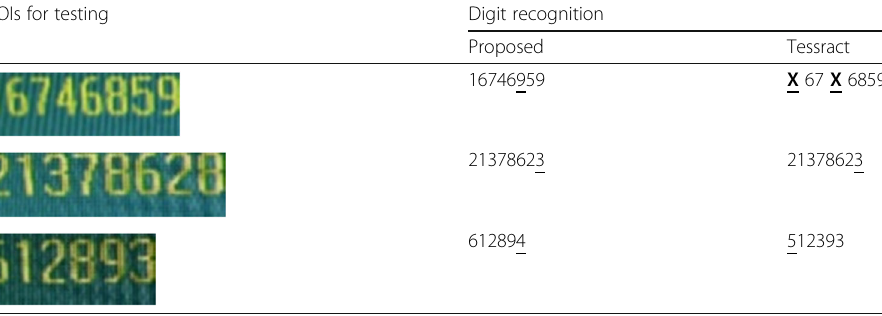
Table 1 Some wrong results of digit recognition (note: the underline means the recognition error and X denotes no